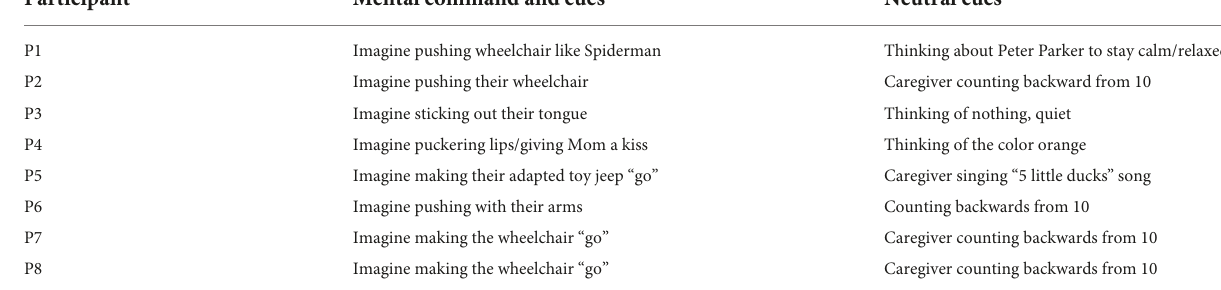
TABLE 1 Participant mental command and neutral strategies and